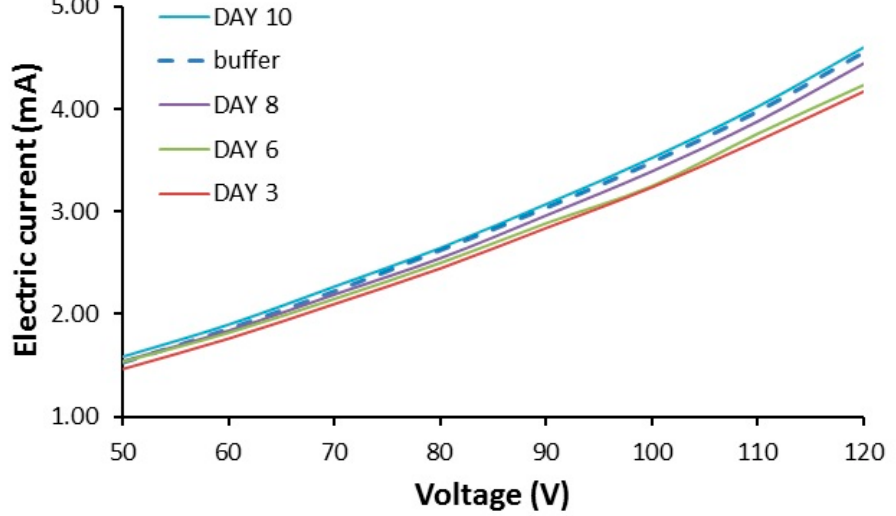
Figure 4. Conductivity of amyloid fiber formation. Five mg/mL, 10 mg/mL, 20 mg/mL, 40 mg/mL, 60 mg/mL, 80 mg/mL, 100 mg/mL lysozyme gels made with glycine solution (10 mM glycine, 150 mM NaCl, pH 2.5) were incubated in a shaker, 500 rpm, for 3 days. Currents through the tubes under different voltages were presented. Tubes filled with the glycine buffer were used as control.